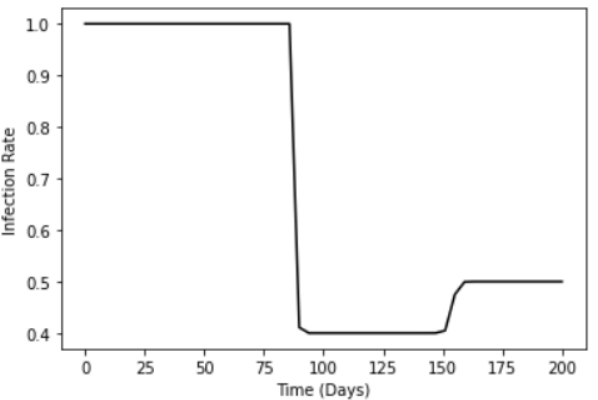
Figure 2. Logistic function to model the infection rate due to compulsory mask wearing m ( t ) for Scenario 2, where one takes into account the